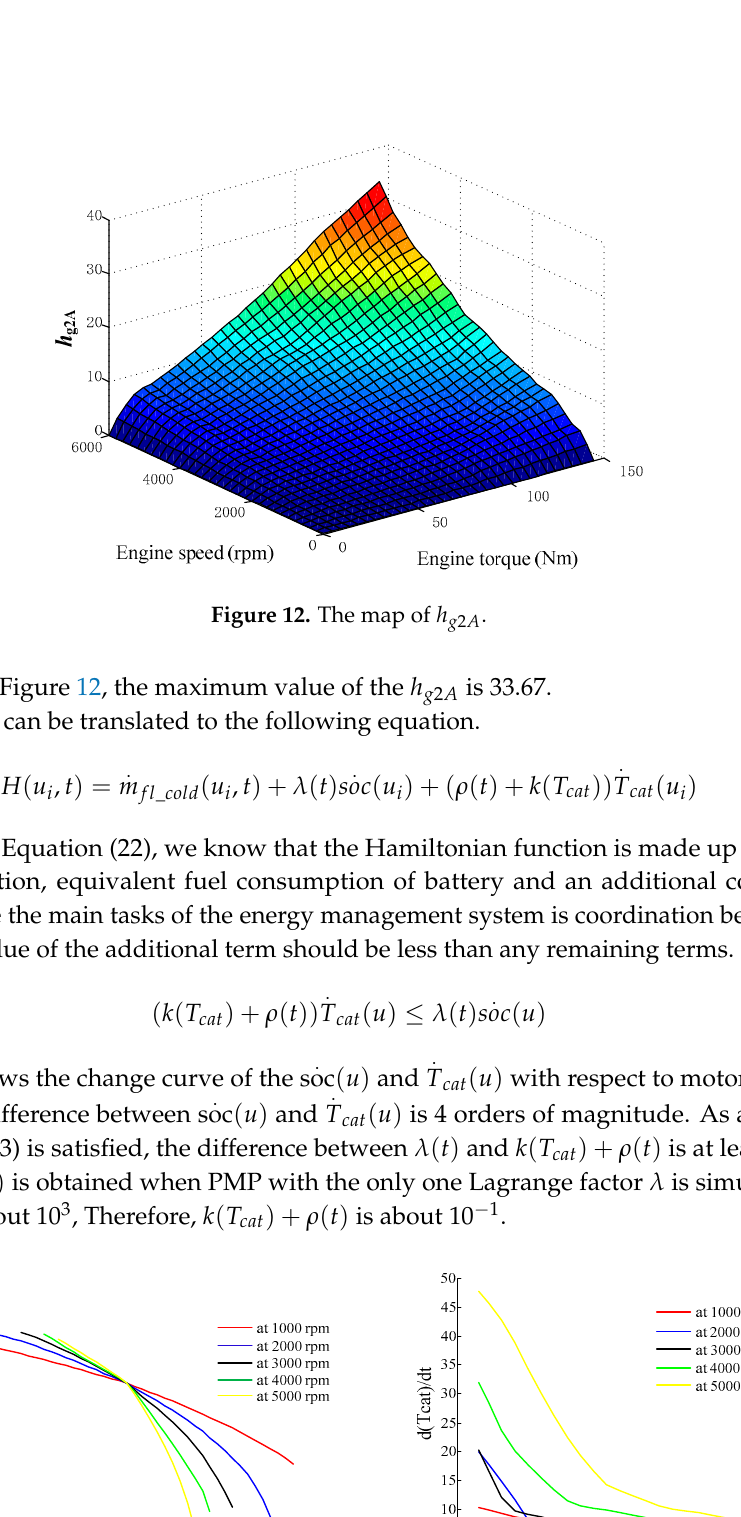
Figure 13. The change curve of the soc( ) u and ( )